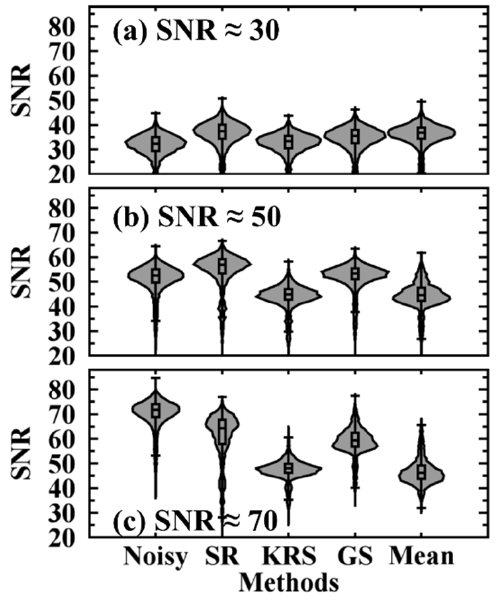
Figure 6. Performance of the four methods at different input SNR levels.